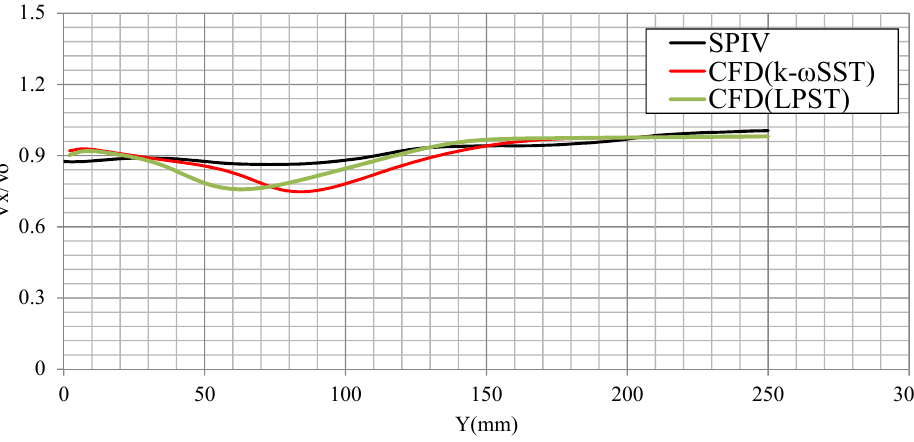
Figure 19. Axial velocity distribution of Model5415 along the horizontal line above propeller shaft. Figure 14 shows a comparison of the wake distribution obtained using the KVLCC2 model. The hull form shown is that of a full ship similar to a JBC. A stern longitudinal vortex can be observed. Figure 15 shows a comparison of the wake distribution obtained using the KCS model. The KCS model is that of a fine hull–form ship (i.e., a container ship). No stern longitudinal vortex hooks were obtained using this model. Figure